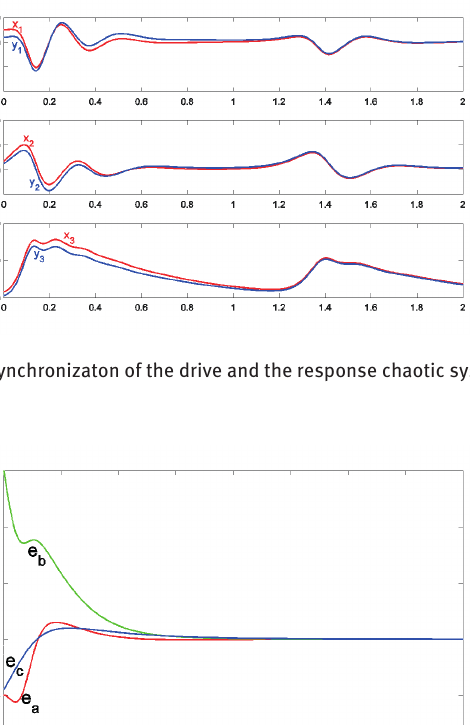
for controlling the behavior of the Zhang chaotic system state variables. Then, the non-identical synchronization of the Zhang chaotic system with unknown parameters are performed by considering the Lü chaotic system as the response system. The stability of the proposed method is proved globally and asymptotically by means of Lya- panov stability theorem. In addition, some numerical sim- ulations are performed to verify the effectiveness of the proposed feedback controllers to obtain adaptive control and synchronization of the Zhang chaotic system. Param- eter estimations errors in numerical simulations support the effectiveness of the proposed control and synchroniza- tion